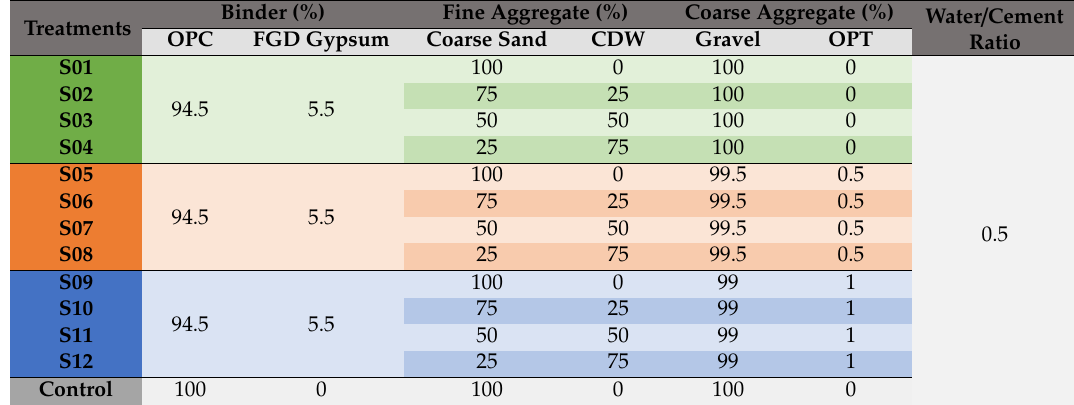
Table 1. Proportions of concrete bricks. Abbreviations: CDW, construction and demolition waste; FGD, flue-gas desulfurization; OPC, ordinary Portland cement; OPT, oil palm trunks. Binder (%) Fine Aggregate (%) Coarse Aggregate (%) Treatments OPC FGD Gypsum Coarse Sand CDW